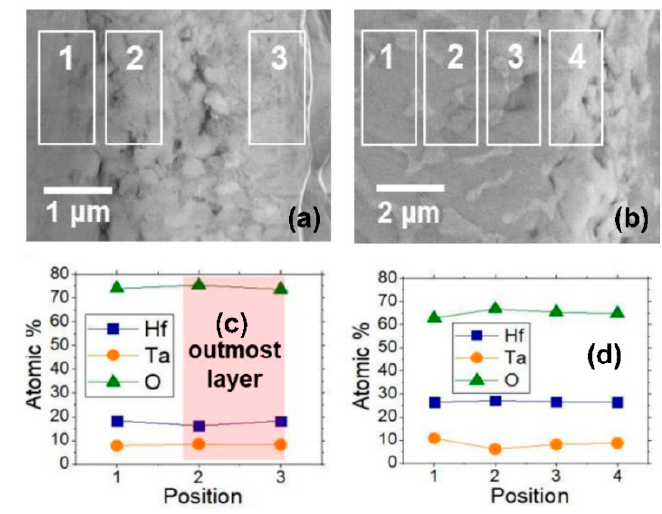
Figure 6. SEM micrographs and EDS results of the ( a , c ) HT-1 and ( b , d ) HT-3 samples after heat treatment in a 4% H 2 -Ar atmosphere.